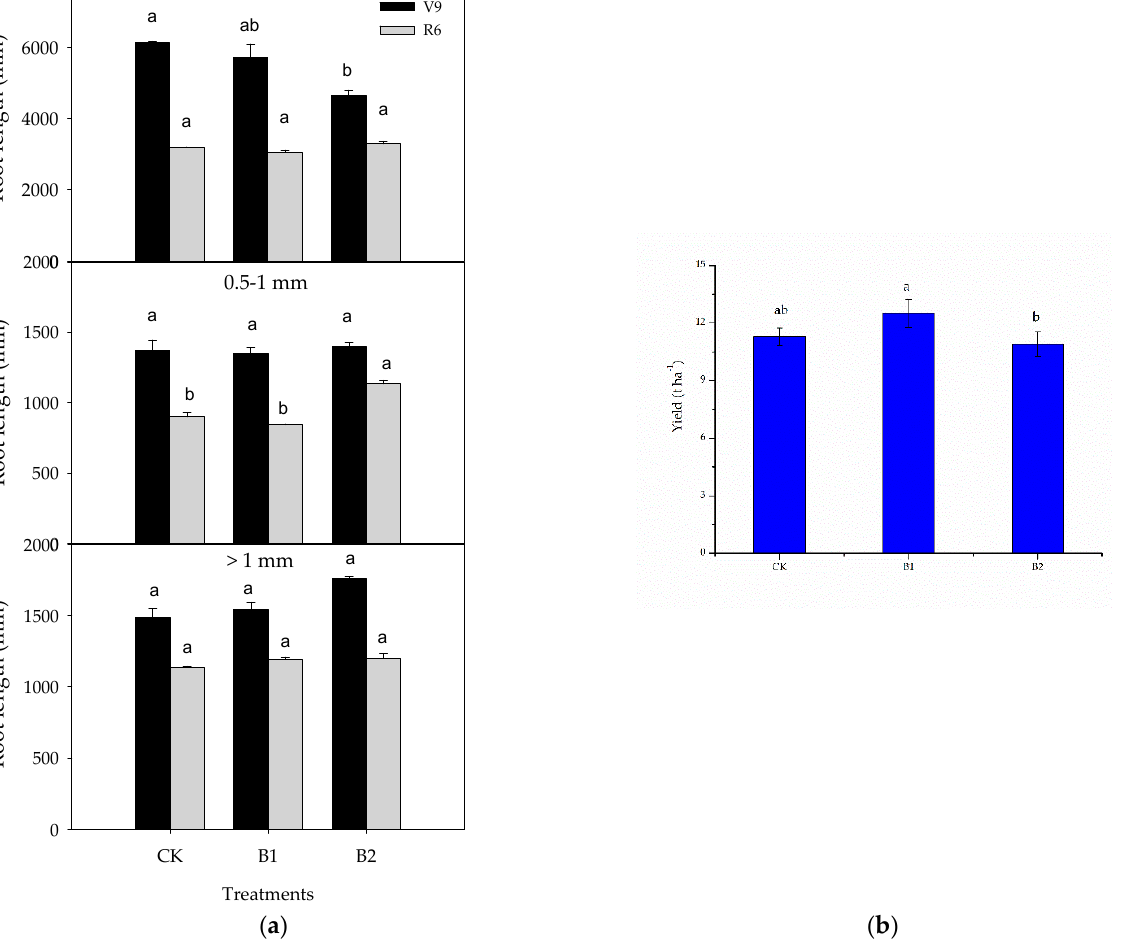
Figure 3. Percentage of maize root lengths in different diameter classes during two growth stages of maize under biochar treatments. Main root axes, diameter < 1.0 mm; first-order lateral roots, diameter 0.5–1.0 mm; and second-order fine roots, diameter < 0.5 mm. Treatment abbreviations (CK, B1, and B2) are defined in Figure 2 caption. Data are mean ± SE ( n = 3). 0 ‐ 0.5 mm